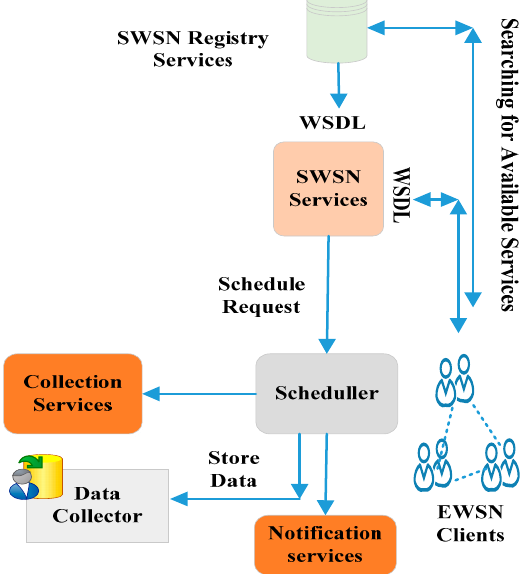
Figure 12. SWSN Dynamic Service Platform [94].